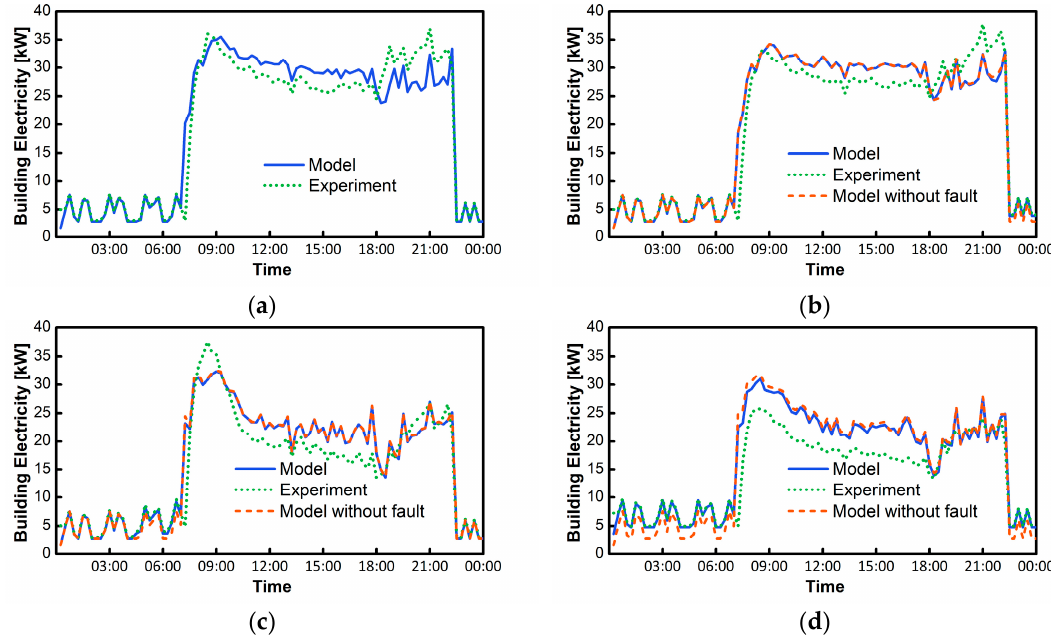
Figure 9. Total building electricity consumptions of baseline and faulted scenarios: lighting setback error. ( a ) baseline; ( b ) delayed onset; ( c ) early termination; ( d ) no setback.